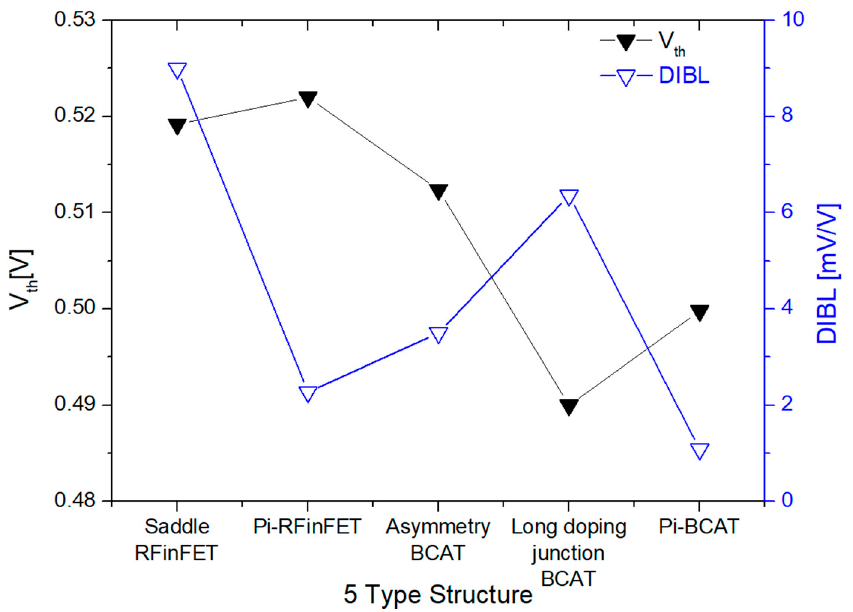
Figure 6. V th and drain induced barrier lowering(DIBL) comparison of five structures.